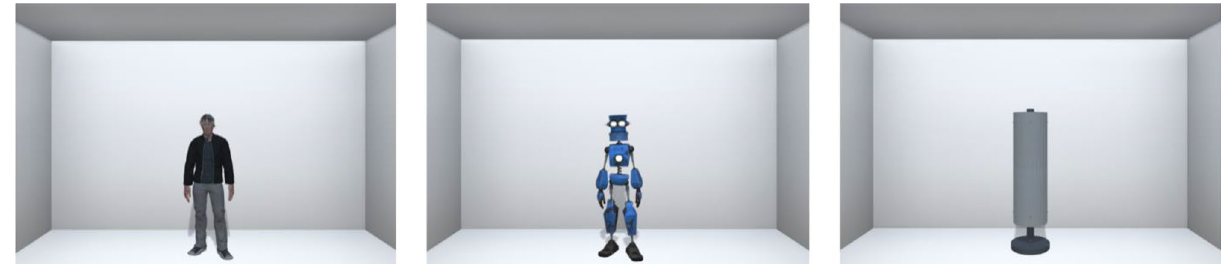
Figure 1. The virtual environment and stimuli used in the four tasks: a neutral human adult male, an anthropomorphic robot and a cylindrical lamp appearing at 300 cm in front of the participant in an undecorated and unequipped